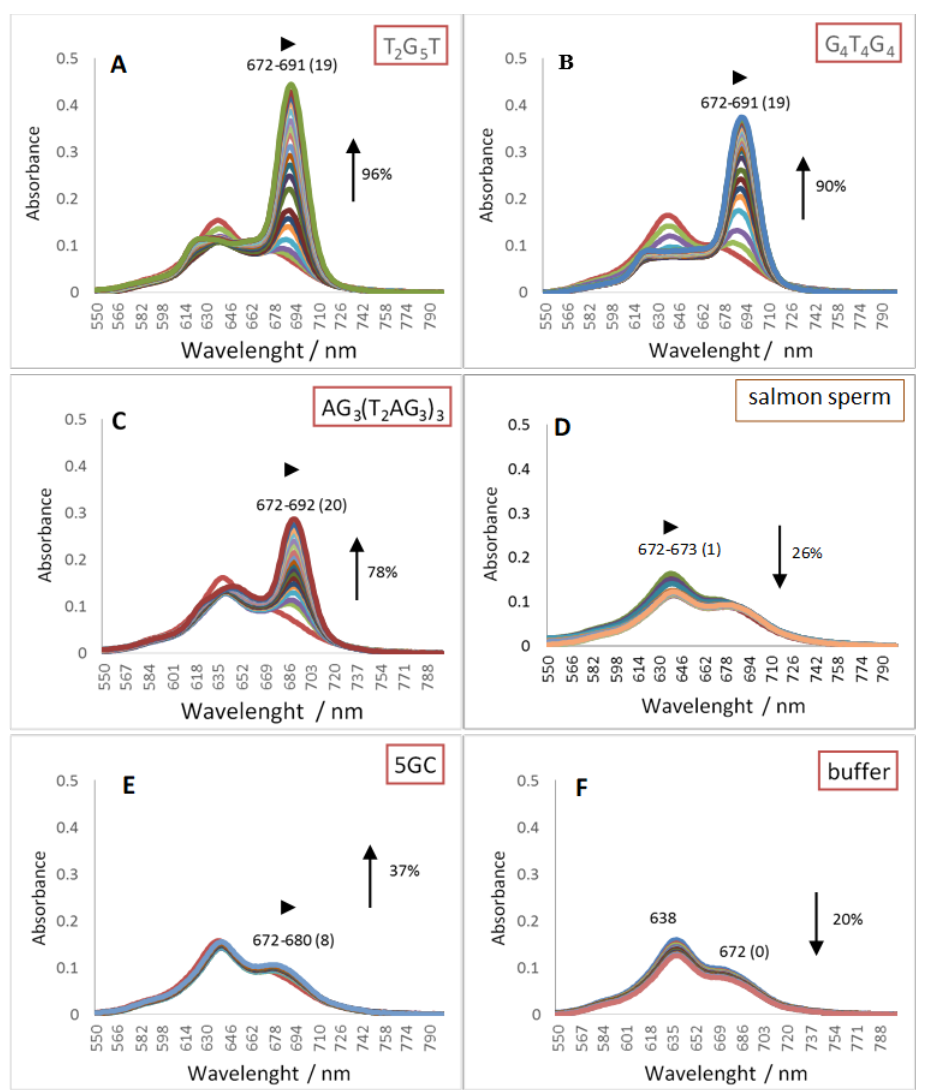
Figure 3. UV-Vis absorption spectra (550–800 nm) for the titrated solutions of ZnPc1 (2.0 µ M) with ( A ) tetramolecular GQ, ( B ) bimolecular GQ, ( C ) unimolecular GQ, ( D ) salmon sperm, ( E ) 5GC, and ( F ) 20 mM PBS buffer with 100 mM KCl.